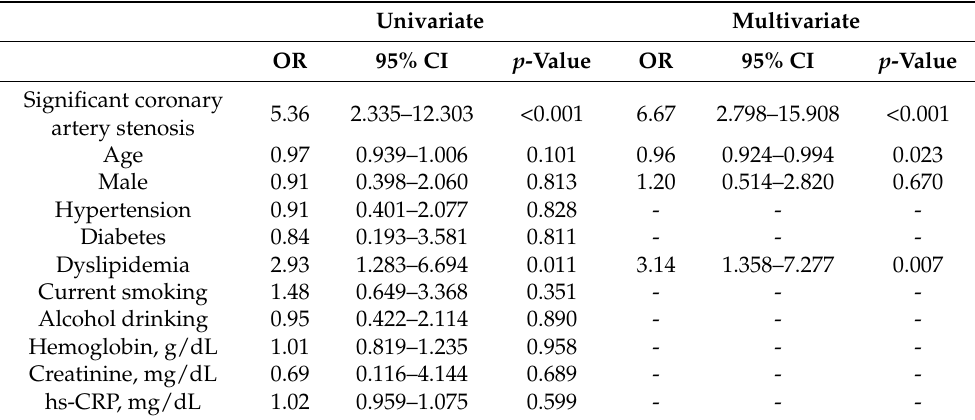
Table 5. Predictors of 1-year ACS in patients with